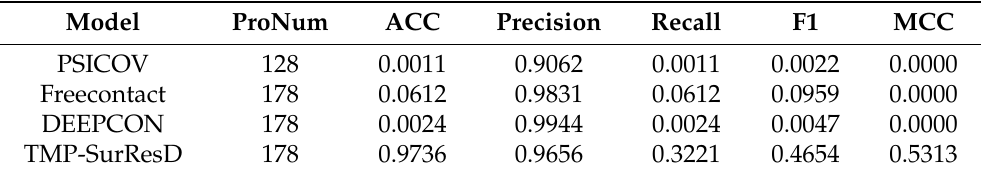
Table 7. Comparison of TMP-SurResD and other residue contact prediction methods based on surface residue 1